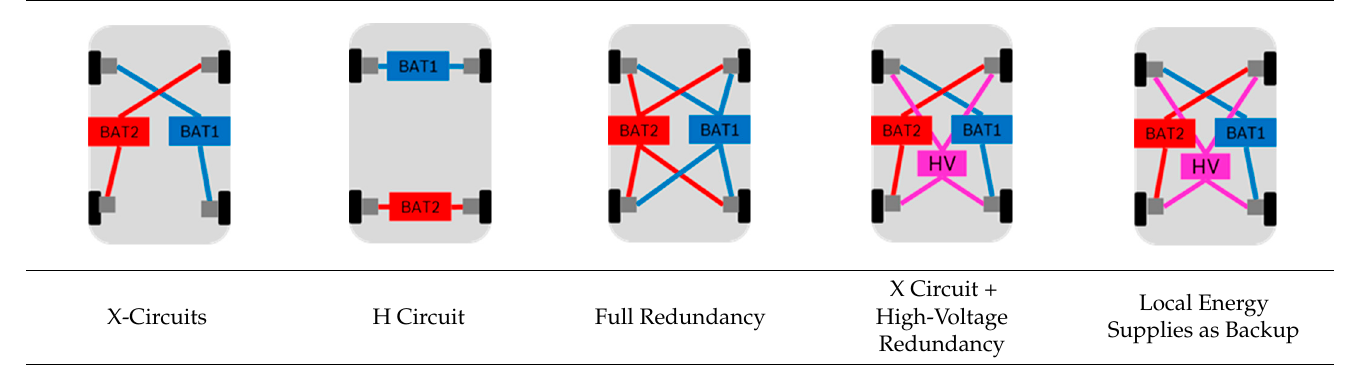
Table 7. Overview of power supply topologies.